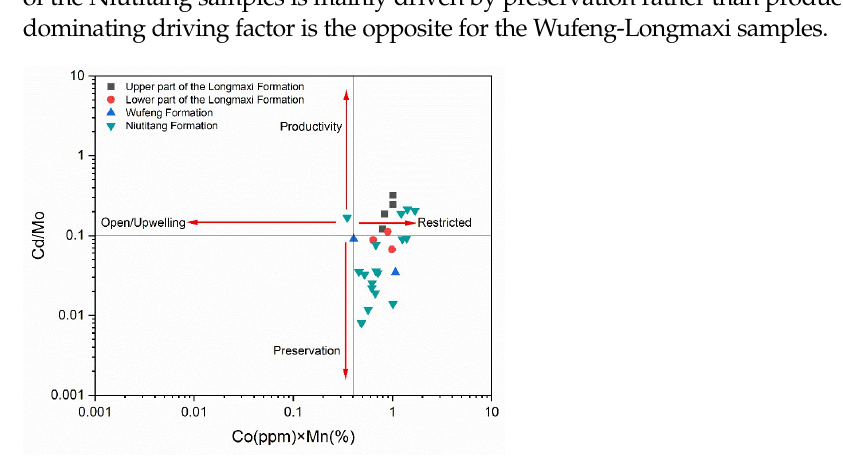
Figure 10. Cd/Mo versus Co (ppm) × Mn (%) for samples. The interpretation polygons are from Sweere et al. (2016) [66].